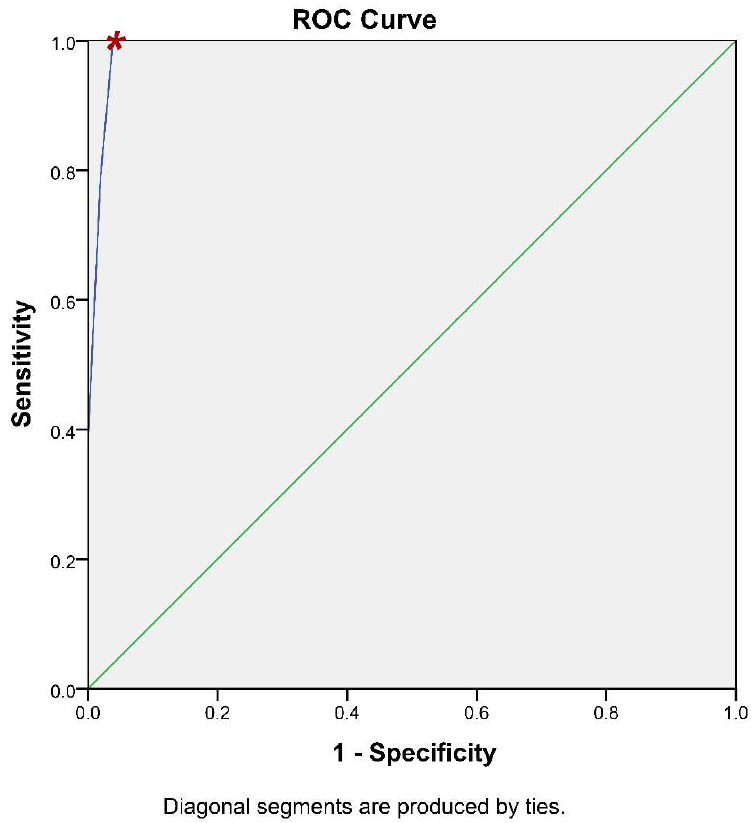
Figure 5. ROC-Curve analysis. iFC evaluation of neoplasia based on G0/G1 and Tumor-index calculation is highly accurate. Sensitivity ( Y -axis) and 1- specificity ( X -axis) for individual cut-off values is presented by the blue line. The selection of a spot in the blue line allows the calculation of the respective sensitivity and specificity, based on a cut-off value. The selected cut-off value is denoted in the curve with a red asterisk.